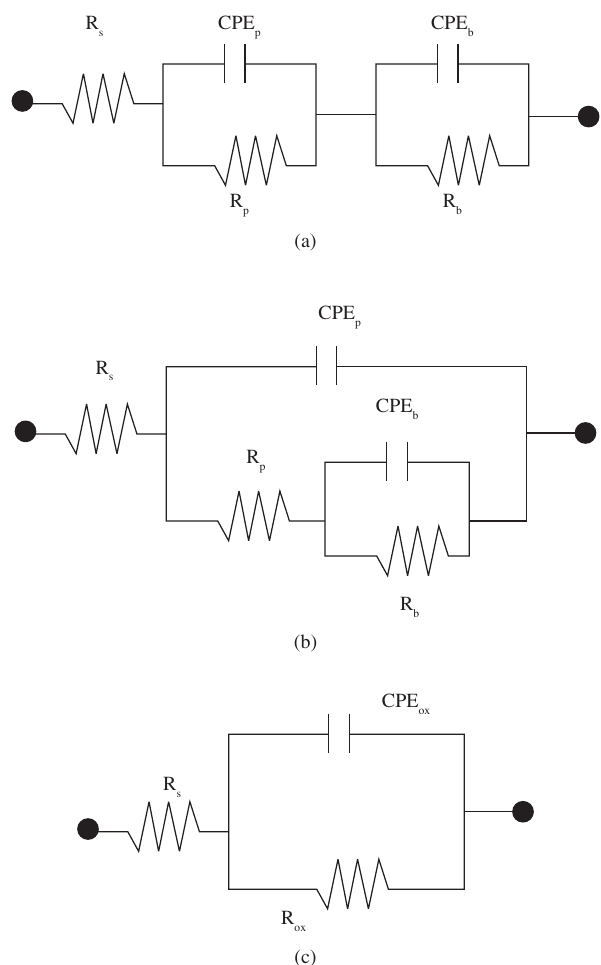
Figure 3. Equivalent electrical circuit used for fitting experimental data obtained at a) OCP; b) 500 mV(SCE); and c) 1300 mV(SCE), which are shown in Figure